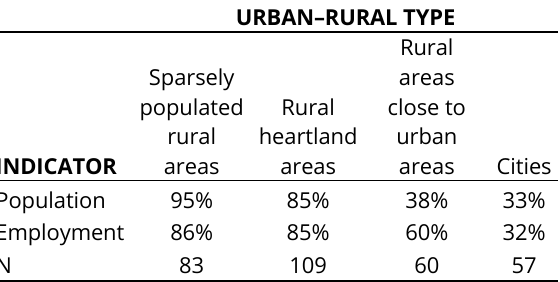
Table 3. Shares of shrinking Finnish municipalities in terms of population and employment per urban–rural type in the medium analysis